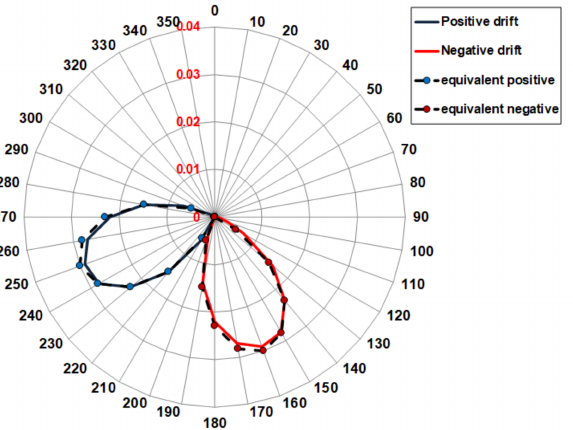
Figure 15. Comparison between Climate-LDR and Equivalent-LDR of the Bagnoli bay; blue solid line represents drift to right when looking offshore, while red solid line represents drift to left when looking offshore; dashed lobes represent the equivalent drifts. Littoral drift in cubic